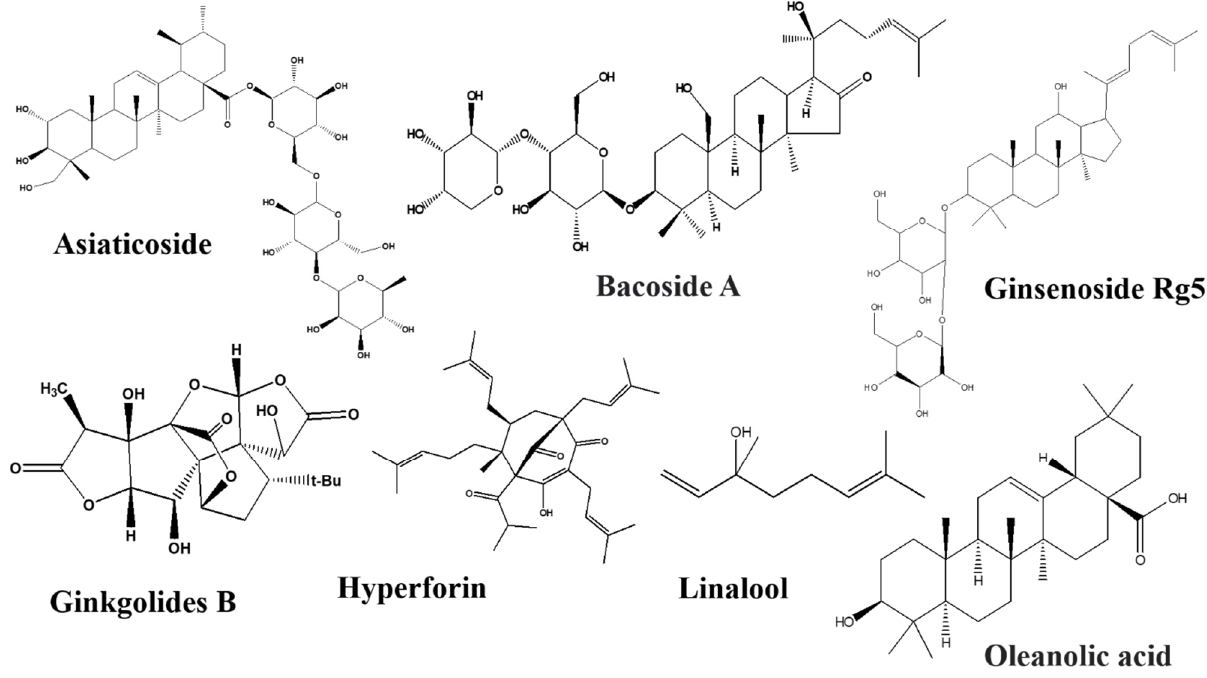
Figure 6. Structures of bioactive metabolites from natural products: Asiaticoside— Centella asiatica ; Bacoside— Bacopa monnieri ; Ginkgolides B— Ginkgo biloba ; Linalool— Lavandula angustifolia ; Ginsenoside Rg5— Panax ginseng ; Oleanolic acid— Pimenta pseudocaryophyllus ; Hyperforin— Hypericum perforatum